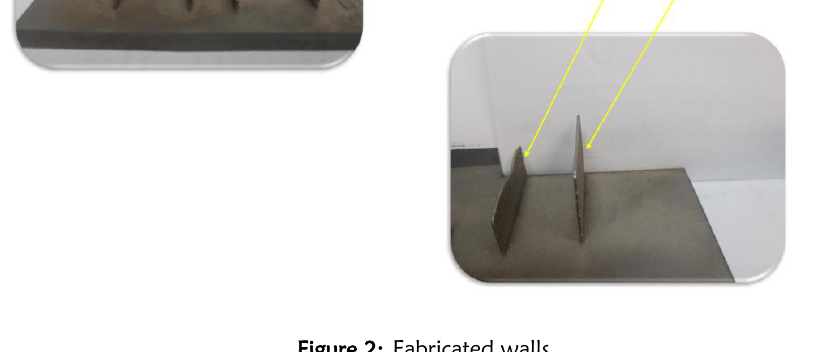
Figure 2: Fabricated walls